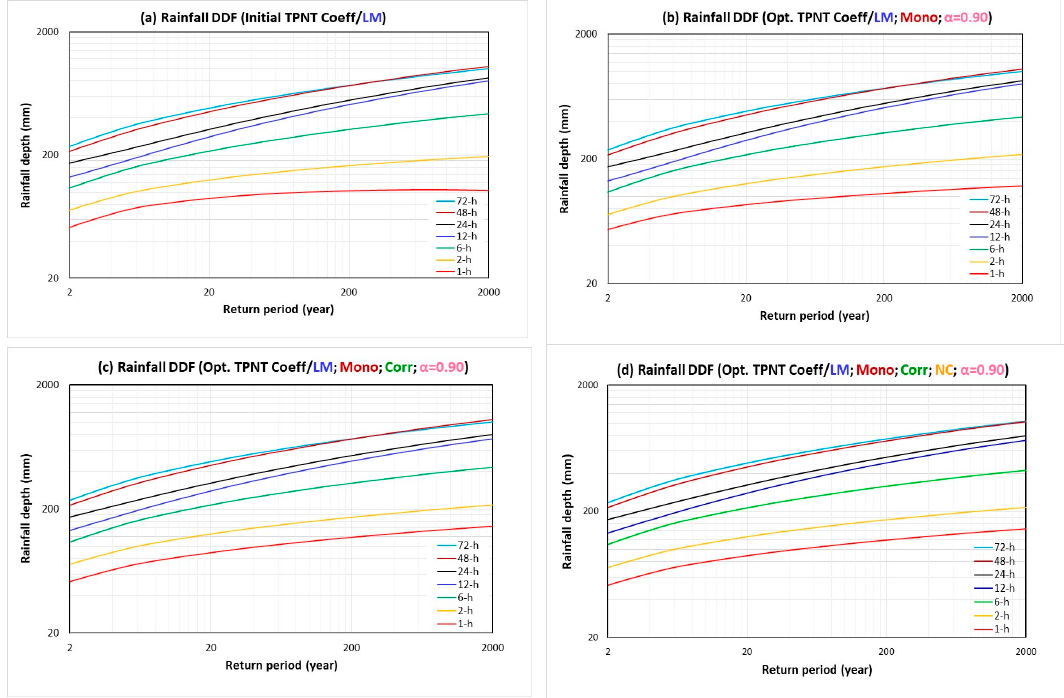
Figure 4. Multivariate TPNT modeling of rainfall depth–frequency relationships of varying durations under different constraints which consider: ( a ) L-moments only; ( b ) L-moments and monotonicity; ( c ) L-moments, monotonicity and correlation; ( d ) L-moments, monotonicity, correlation and no crossover.